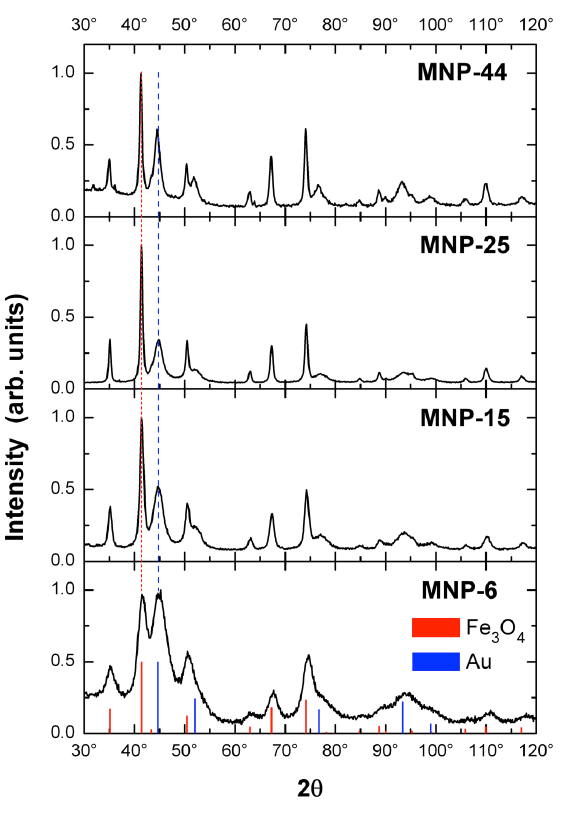
Figure 2: XRD patterns of Fe 3 O 4 –Au NPs. Panels are sorted by mag- netic NP size from bottom to top – samples MNP-6, MNP-15, MNP-25 and MNP-44, respectively. The intensity of each diffractogram is normalized to the strongest peak. The red and blue vertical lines repre- sent the angular position and relative intensity of reference bulk mag- netite and gold phases.